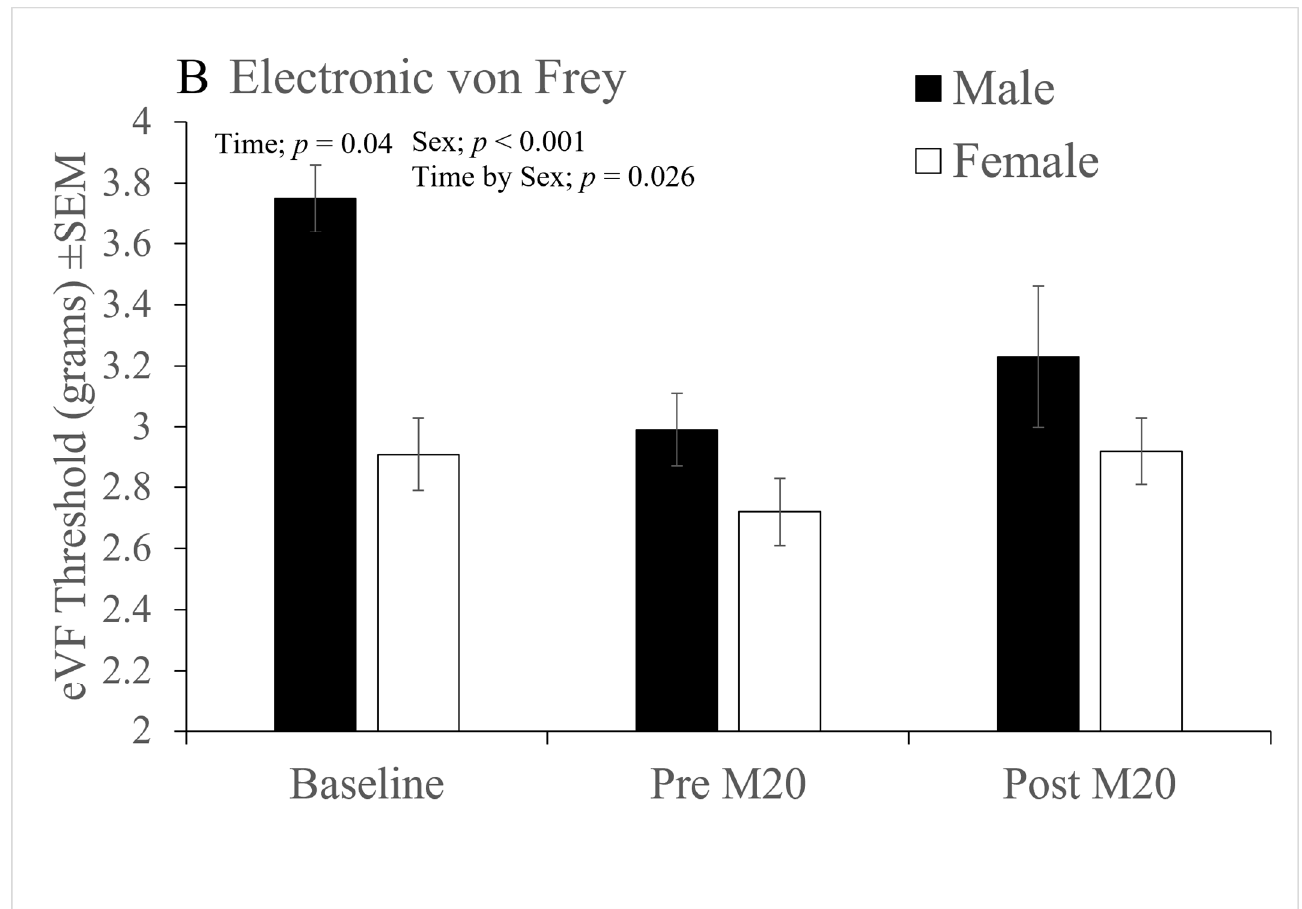
Figure 4. ( A ) Mean mouse grimace scale scores at baseline and on the day of euthanasia (±SEM) in cancer and control groups. Cancer-bearing mice showed a significantly greater increase in scores from baseline to euthanasia (significant ‘Time’ by ‘Treatment’ interaction). ( B ) Electronic von Frey (eVF) thresholds (recorded at baseline and on the day of euthanasia, when mice were recorded both before (Pre) and 1 h following (Post) administration of 20mg/kg meloxicam (M20). Note that males had significantly higher initial eVF thresholds so showed a relatively greater decline over the study duration (Significant effects of ‘Time’ and ‘Sex’ and significant ‘Time’ by ‘Sex’ interaction). Meloxicam treatment had no beneficial effect. Cancer/Control, n = 16 (seven males and nine females); Control, n = 16 (7 males and 9 females).